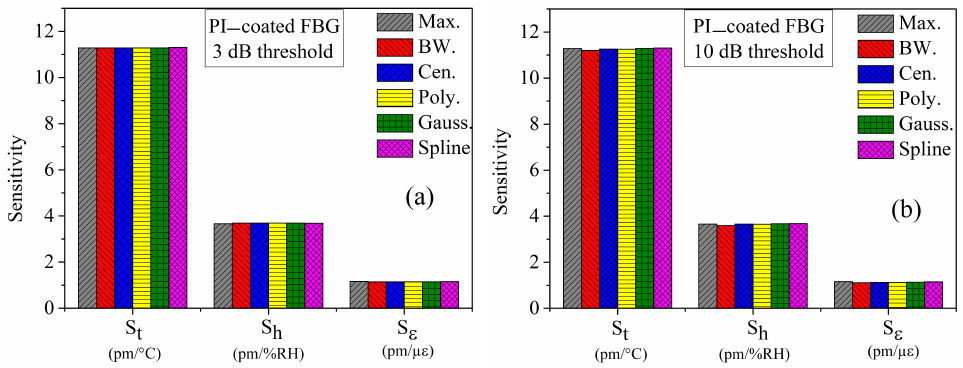
Figure 9. Comparison of main sensitivities of temperature, humidity, and strain, calculated by different peak tracking methods for PI-coated FBG for thresholds of ( a ) 3 and ( b ) 10dB.